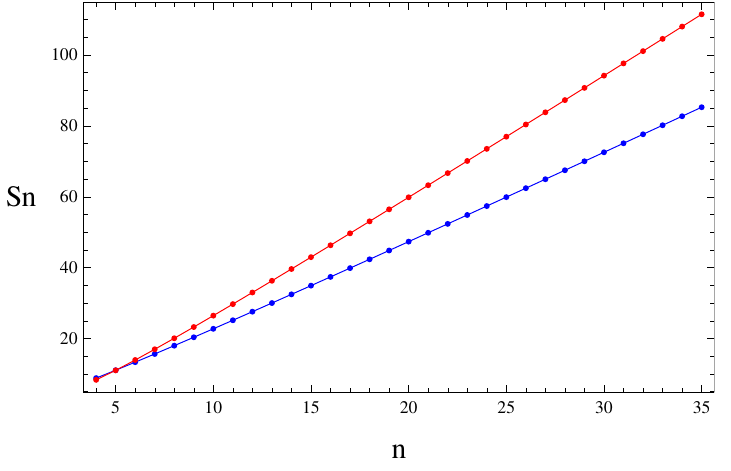
Figure 17 . The entanglement entropy of gauge (cid:12)eld with two di(cid:11)erent trivial centers.The red (top) line corresponds to the trivial with degree of freedoms removed, while the blue (bottom) line corresponds to the usual trivial